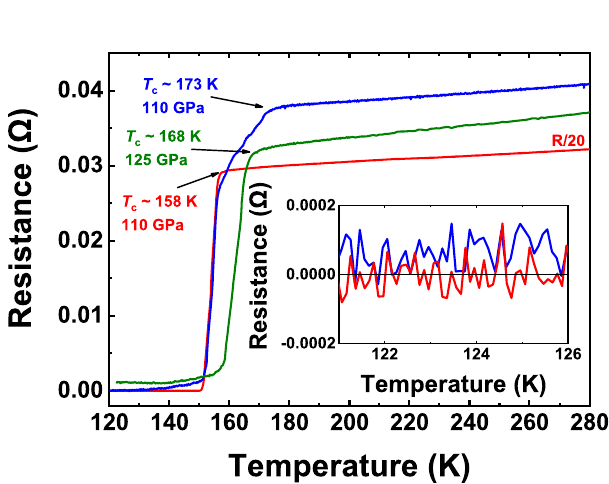
~11.6° in the inset) are masked, and the continuous background is removed before performing the integration and Rietveld analysis. The Rietveld fi t parameters are R R wp =0.46%and p =0.80%.Theweakpeaksmarkedwithasterisksarefromthe mmm -tetrahydride. b Schematic diagram of the crystal structure of P 6 (La,Ce)H 9 .